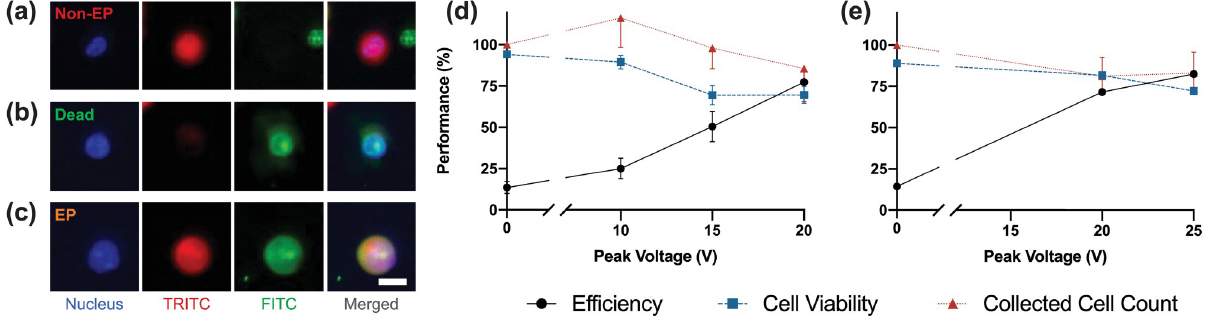
Fig 2. Optimization of electroporation parameters for HCC827 GR6 and wt cells. Microscopic images of HCC827 GR6 cells collected post- electroporation after intracellular delivery of membrane-impermeable fluorophore YOYO-1 (FITC) with Calcein Red-Orange AM (TRITC) counterstain as viability indicator. Cells were labeled with viable nucleus stain Hoechst-33342 (DAPI, Nucleus) prior to electroporation experiments. (a) Live cells that were not electroporated, indicated by the absence of YOYO-1 signal, (b) Dead cells lysed by the electroporation process characterized by the absence of Calcein Red-Orange AM signal, but uptake of YOYO-1, (c) Successful intracellular delivery of YOYO-1 to live cells, indicated by dual fluorescence of YOYO-1 and Calcein Red-Orange AM. Merged image of all 3 fluorescent channels is shown on the far right of the panel. Scale bars represent 25 μ m. Efficiency (black), viability (blue), and collected cell count (red) were obtained for (d) HCC827 GR6 and (e) HCC827 wt cells. Error bars represent the standard error of the mean (n = 3, > 150 cells per